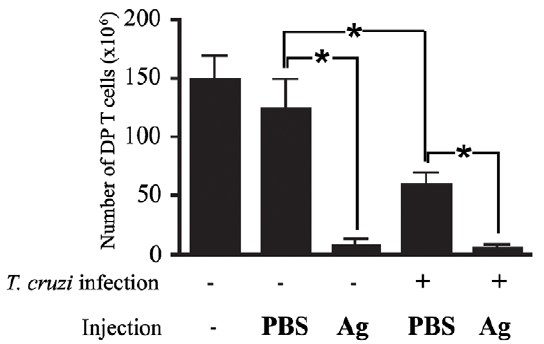
Figure 4. CD4 + CD8 + T cell numbers in thymus of T. cruzi infected OVA TCR transgenic mice. OVA-TCR transgenic mice noninfected or infected with T. cruzi (9 days post-infection) were injected i.v. with 0.5 ml of 450 mM solution of OVAp323–339 daily for 3 days and thymocytes were isolated on the fourth day for quantification of double-positive CD4 + CD8 + T cells by flow cytometry. For control, mice were injected with 0.5 ml of PBS instead of the cognate antigen as indicated in the histogram. All numbers are given in 10 6 . Each value represents the mean of total DP cell numbers in 4-8 mice per group. Data are expressed as mean 6 standard error of triplicate measure- ments of one out of two representative experiments. *Differences between groups are significant ( P , 0.05). These data are representative of two independent experiments using five mice per group.